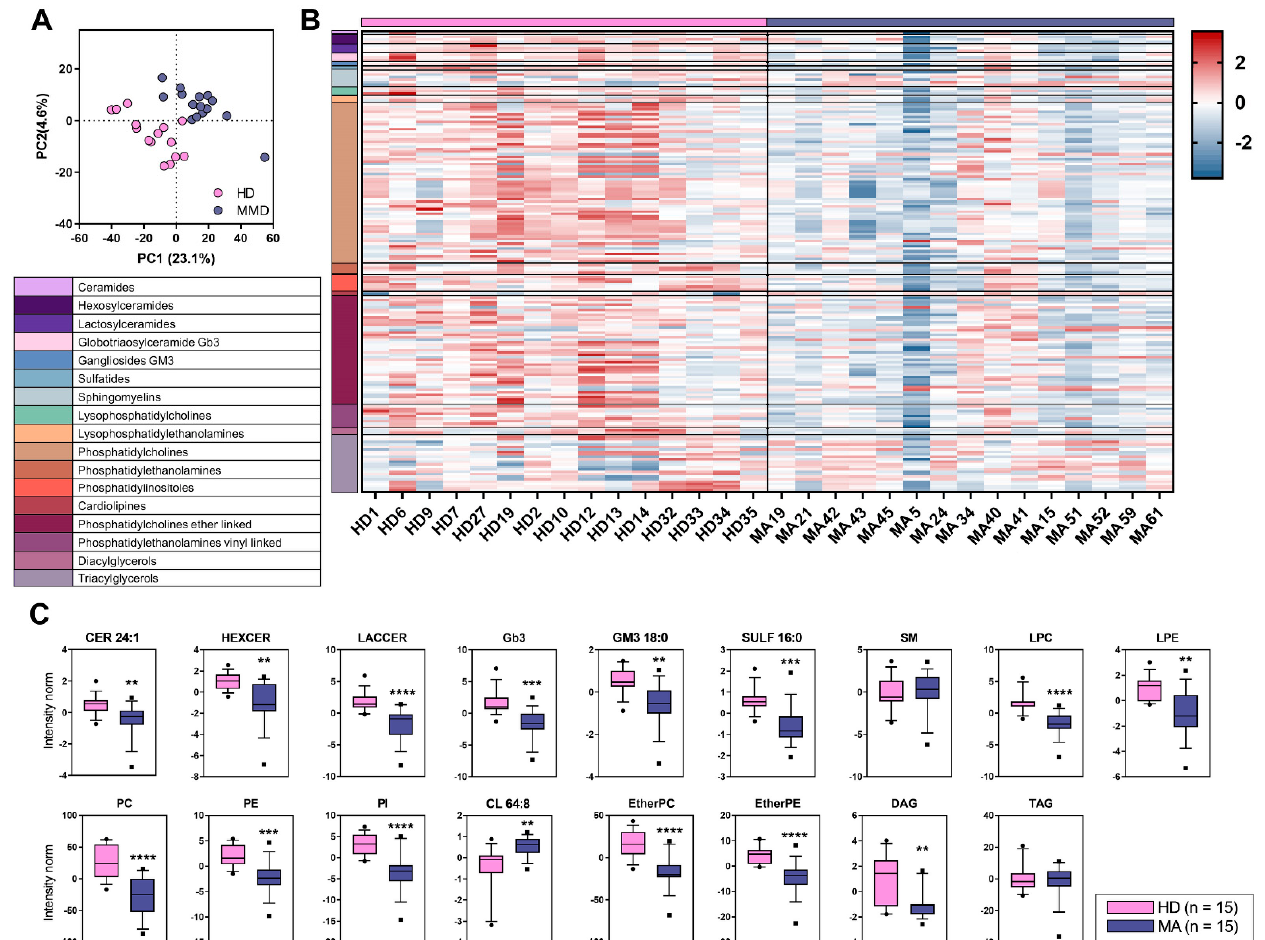
Figure 3. Plasma lipid alteration in MA patients (n = 15) in comparison to age and sex matched healthy donors HD (n = 15). ( A ) Discriminant analysis (score plot) of the lipidome in HD and MA patients. The axes are ranked according to their importance in the group discrimination. In the x-axis, component 1 (PC1, 23.1%) represents the maximum of the separation that can be reached within these clusters and variables, whereas, in the y-axis, component 2 (PC2, 4.6%) represents the direction that contains the most remaining variance. ( B ) Heatmap of the lipids highly correlated with the disease (n = 175), chosen within those with a Variance Importance in Projection (VIP) score >1.5, ordered by lipid classes, coded by different colors. The concentrations were autoscaled and log-transformed for visualization. The color-scale differentiates values as high (red), average (white), and low (blue). ( C ) Boxplots represent the trends in lipid class concentrations in HD and MA patients. The boxes represent data obtained in the range 25th–75th percentile; the line across the boxes indicates the median value; the lines above and below the boxes indicate extreme values (10th or 90th percentile). If not specified with fatty acid composition (e.g., 24:1, 18:0, 16:0, 64:8), the boxplot refers to the lipid class considering discriminant lipids only. Data were reported as log-transformed and auto-scaled mass intensities (Intensity norm). Outliers are displayed as separate points. Statistical significance was evaluated by unpaired t -test. p values are schematized as follows: ** < 0.01; *** < 0.001; **** < 0.0001.